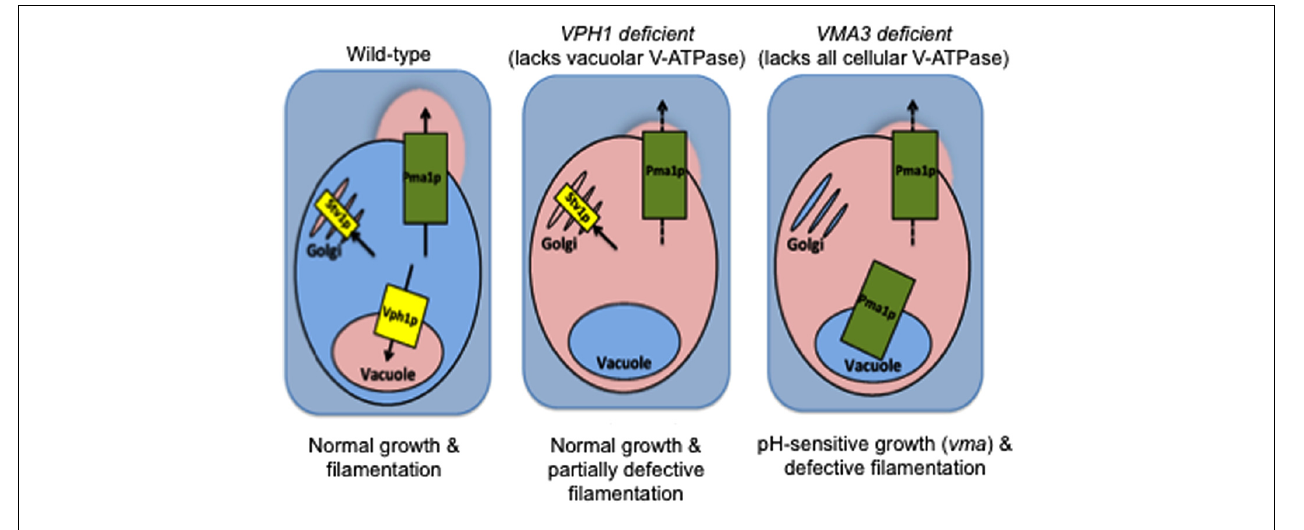
FIGURE 2 |V-ATPase in non-vacuolar organelles (Stv1p-containing complexes) plays a yet unknown role in C. albicans virulence .Wild-type: When functional,V-ATPase-mediated acidification of vacuoles, Golgi, and secretory vesicles maintains organelle pH and supports traffic of Pma1p to the cell surface for proton efflux and maintenance of an alkaline cytosol. VPH1 deficient : C. albicans grows normally at neutral pH when only Vph1p-containingV-ATPase complexes (vacuolar membrane) are missing. Only modest filamentation defects are obvious, despite the concomitant vacuolar alkalinization and defective Pma1p activity (Raines etal., 2013